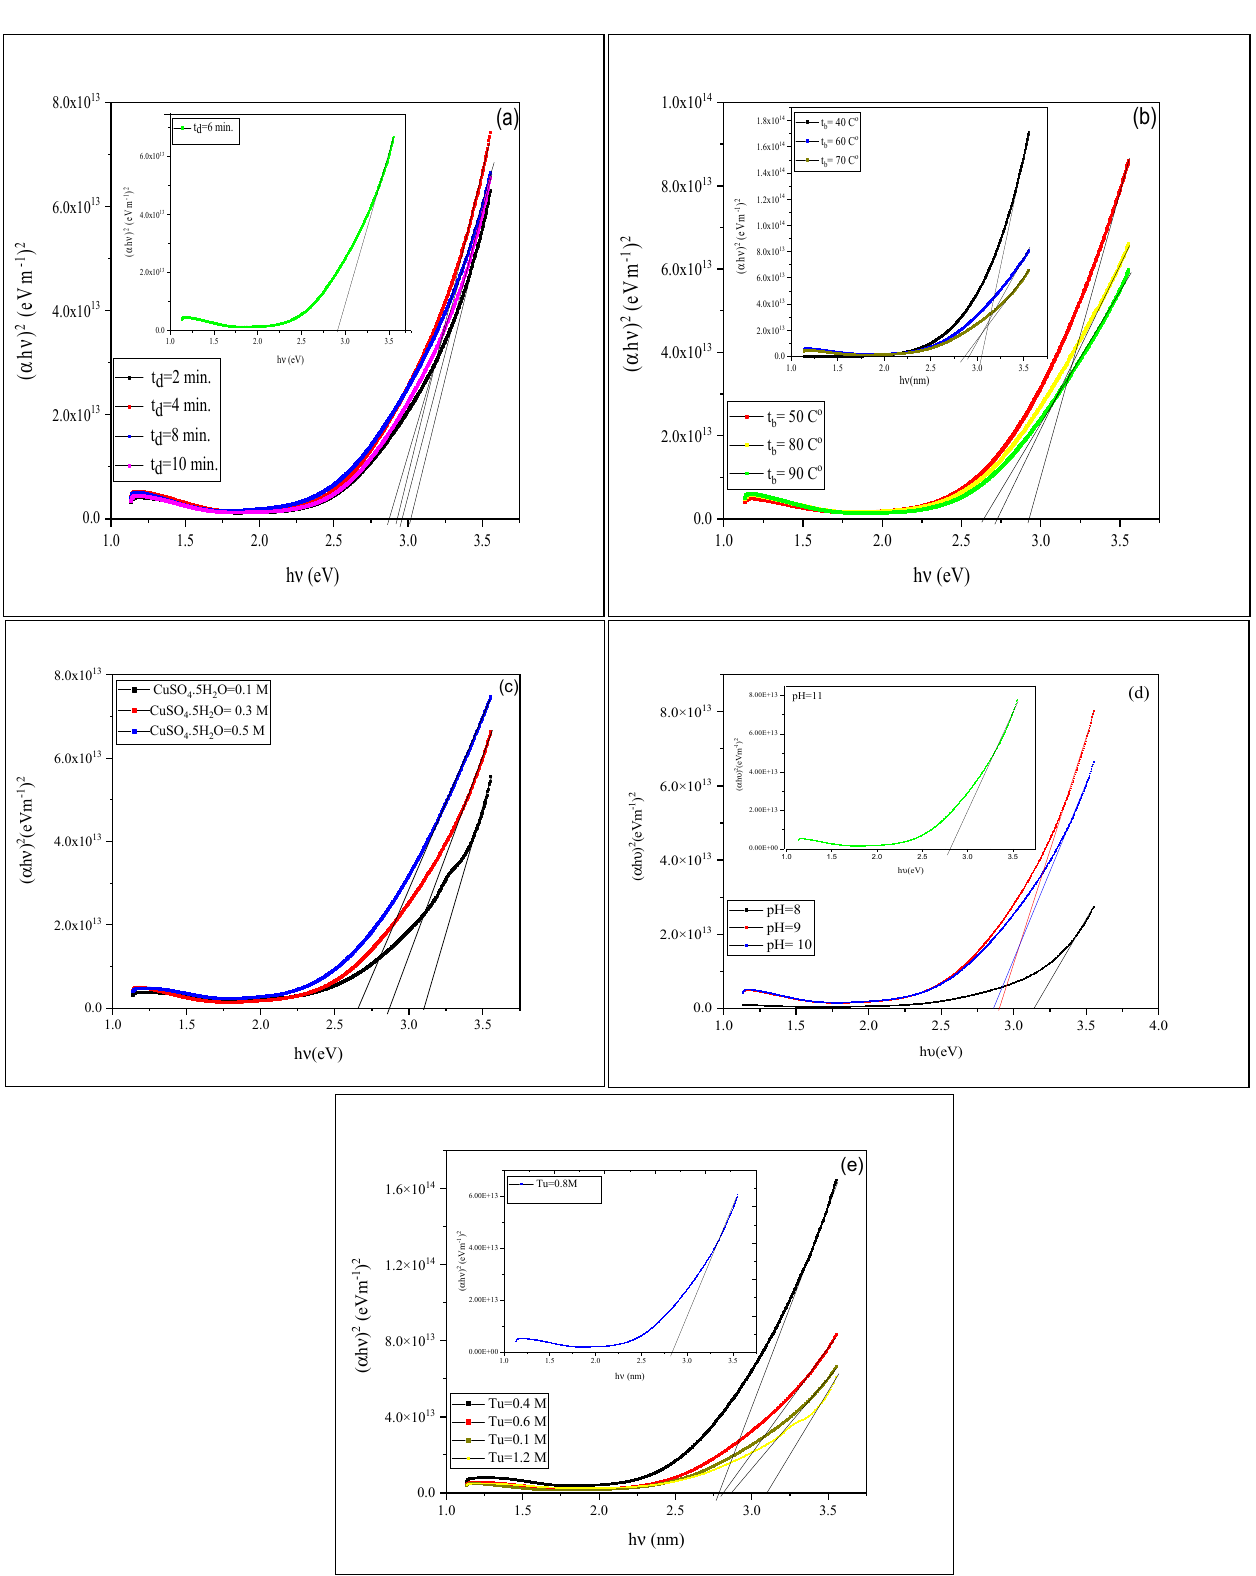
Figure 6. Variation of ( α h υ ) 2 with (h υ ) with deposition parameters): ( a ) Deposition time, ( b ) bath temperature, ( c ) CuSO 4 .5H 2 O concentration, ( d ) pH value, and ( e ) SC (NH 2 ) 2 Table 2. Bandgap variation with different deposition parameters.